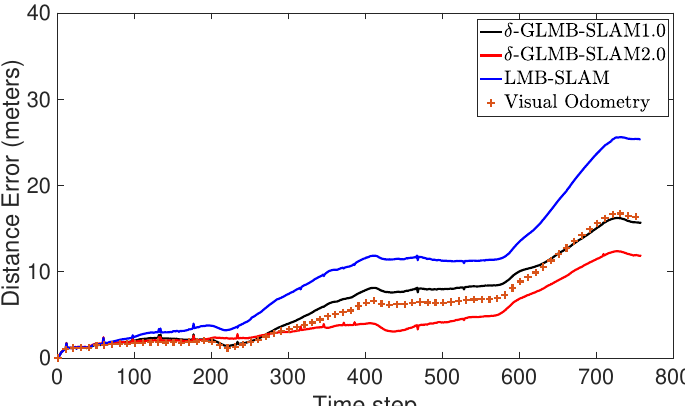
Figure 11. Comparison of the Euclidean distance error between the estimated and ground truth trajectories verses time